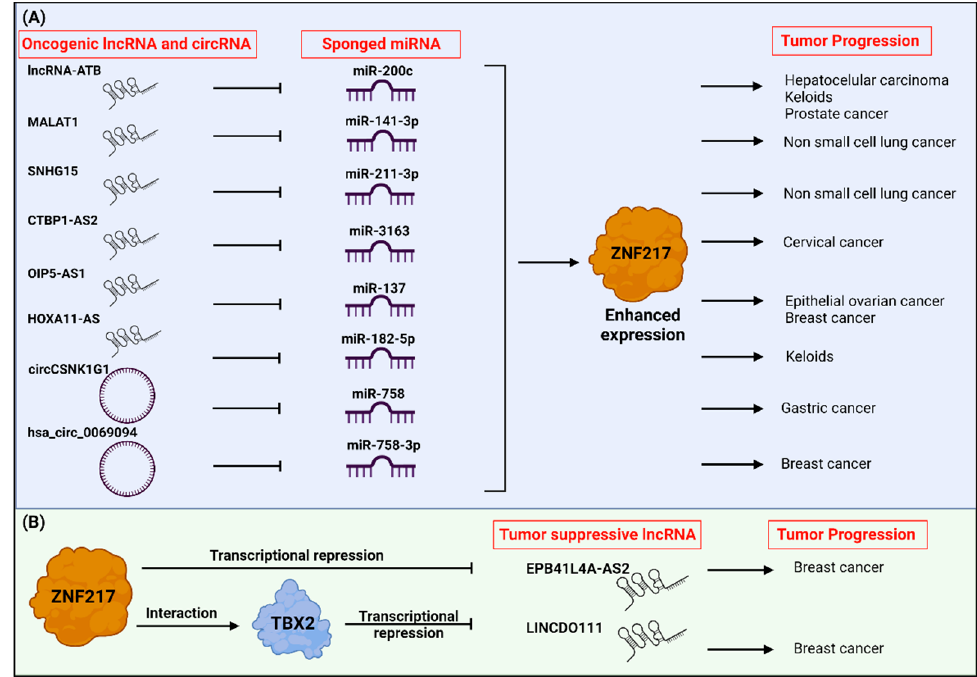
Figure 4. Interplay between ZNF217 and ncRNA promotes tumor progression. ( A ) lncRNA and circRNA sponge miRNA preventing their inhibition of ZNF217 and, thereby, leading to enhanced expression of ZNF217 that promotes tumor progression. ( B ) ZNF217 regulates the expression of tumor-suppressive lncRNAs through transcriptional repression. Created with Biorender.com.